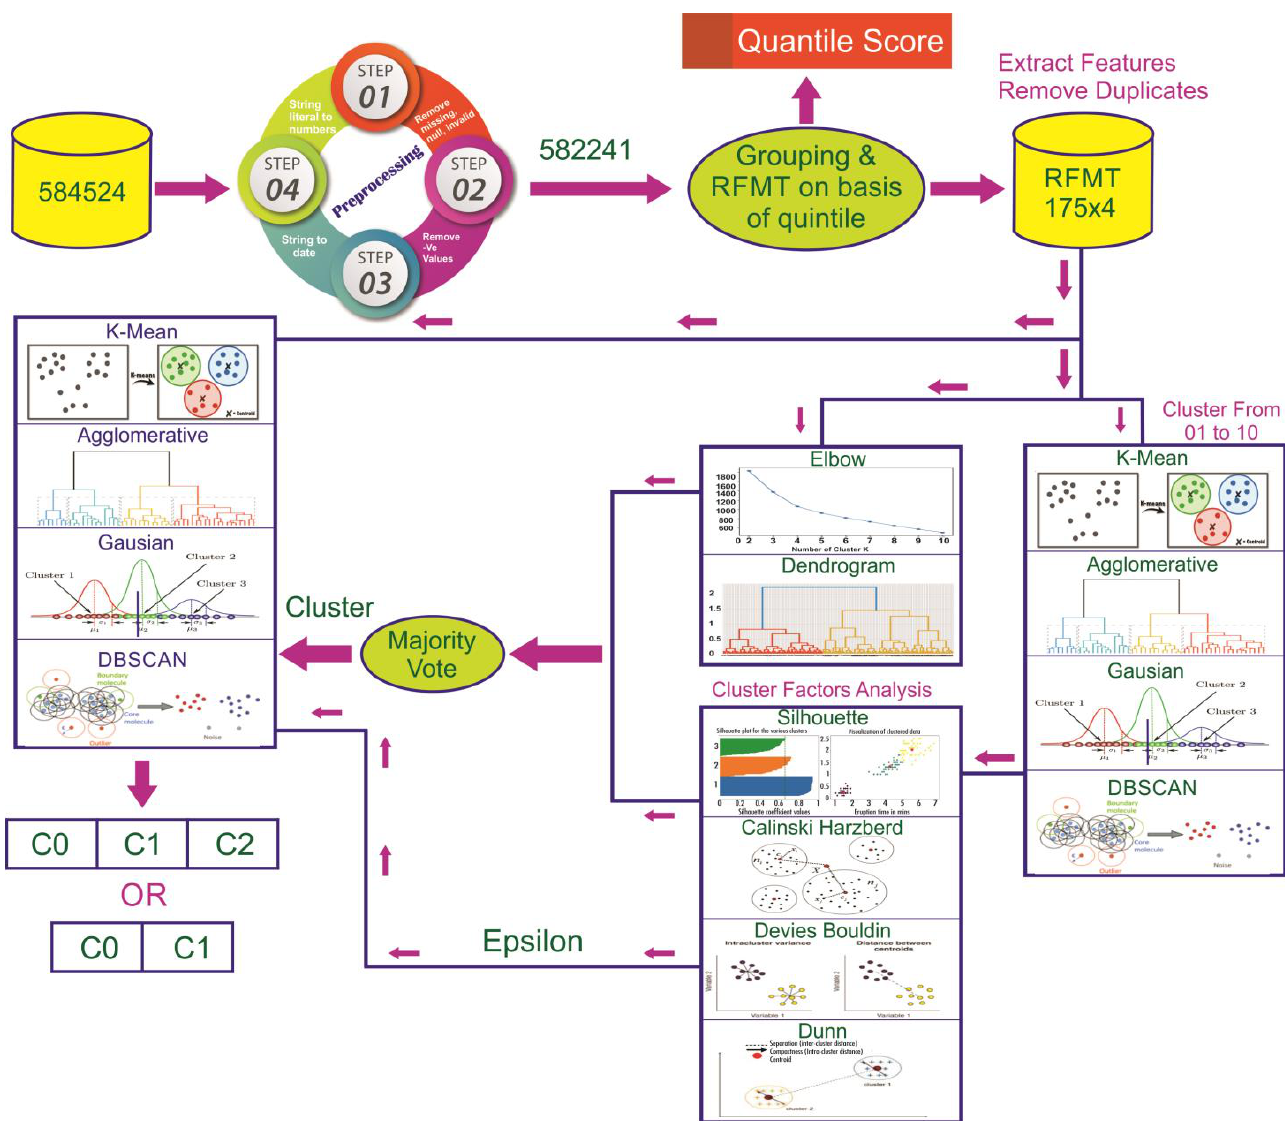
Figure 1. Proposed customer segmentation framework.